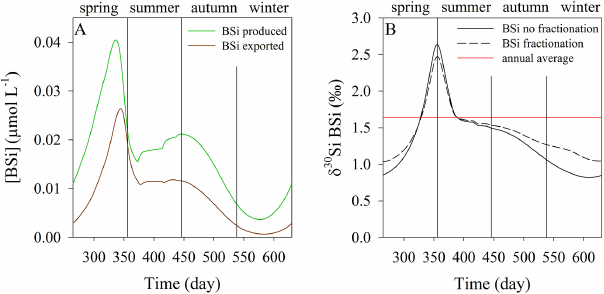
Fig. 8. (A) Annual evolution of the BSi production and the exported BSi outside of the ML, and (B) annual behaviour of the δ 30 Si of the BSi exported outside of the ML (on the sediment) from the initial run (without fractionation during BSi dissolution) and from the run with fractionation during dissolution. The red line represents the mass-weighted average value of the δ 30 Si of the BSi exported for the runs with and without fractionation during BSi dissolution (1.64 and 1.65‰,